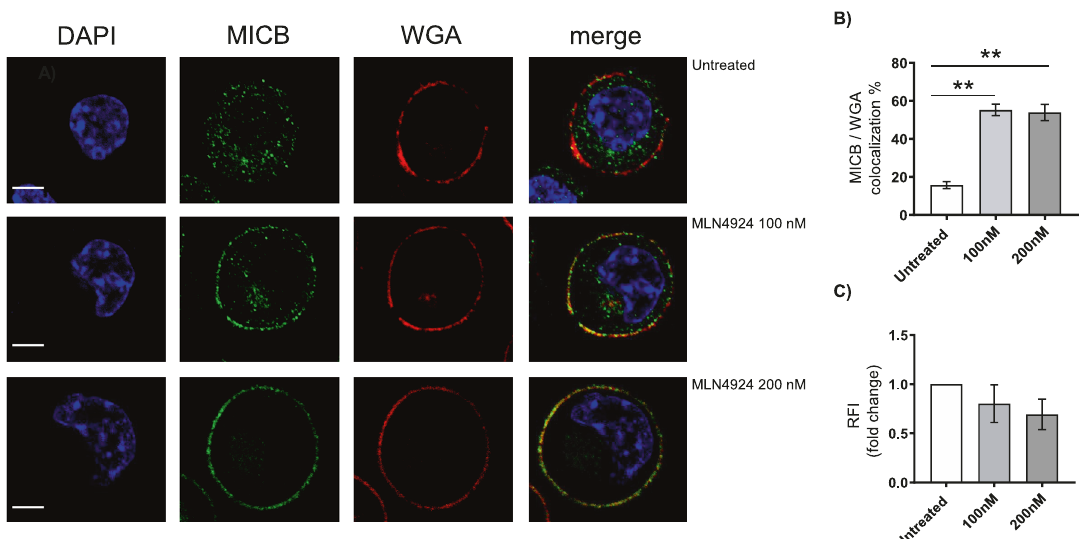
Fig. 7 Cellular relocalization of MICB by MLN4924 in MM cells. A MICB expression analyzed by confocal microscopy in SKO-007(J3) cells untreated or treated with the indicated concentrations of MLN4924 for 72 h. Cells were fi xed with paraformaldehyde and plasma